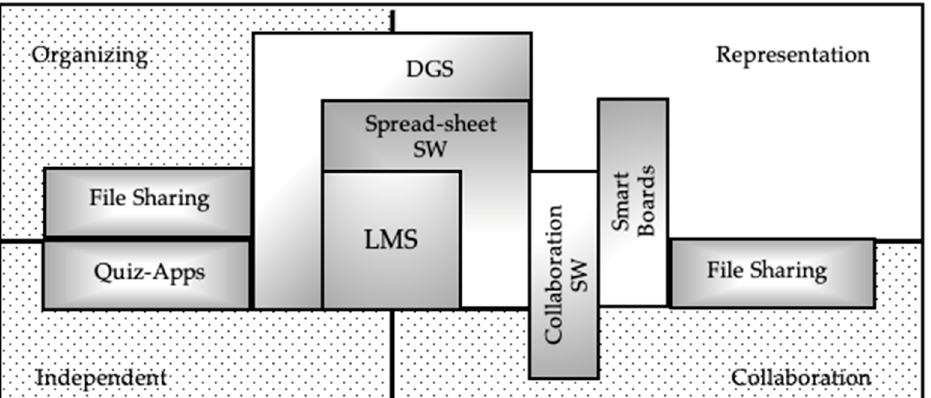
Figure 1. Examples of dT by the four technology groups Organizing , Representation , Collaboration , and Independent .